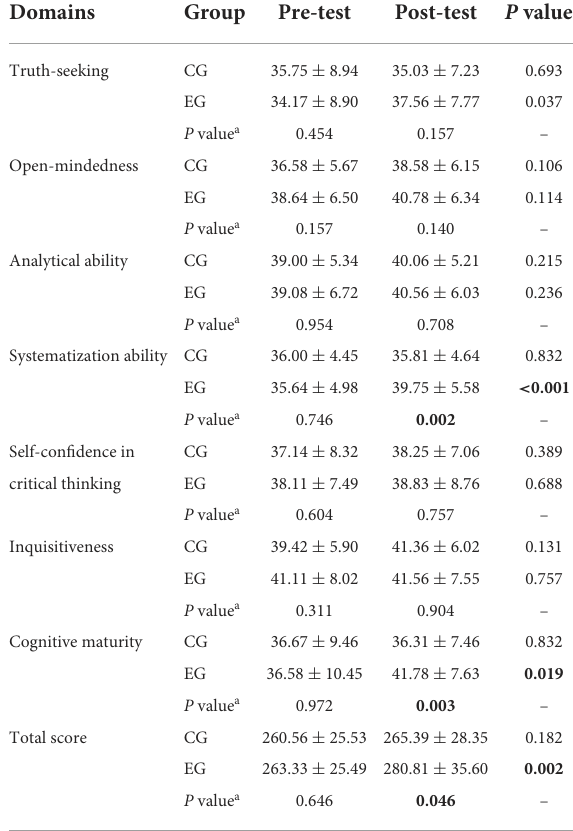
TABLE 3 Comparison of CTDI-CV and its dimension score in pre- and post-test and between two groups (M ± SD).